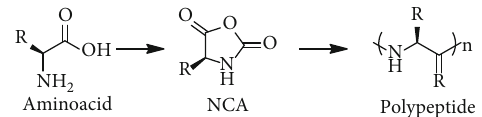
Scheme 1: Synthesis of polypeptides via ROP of